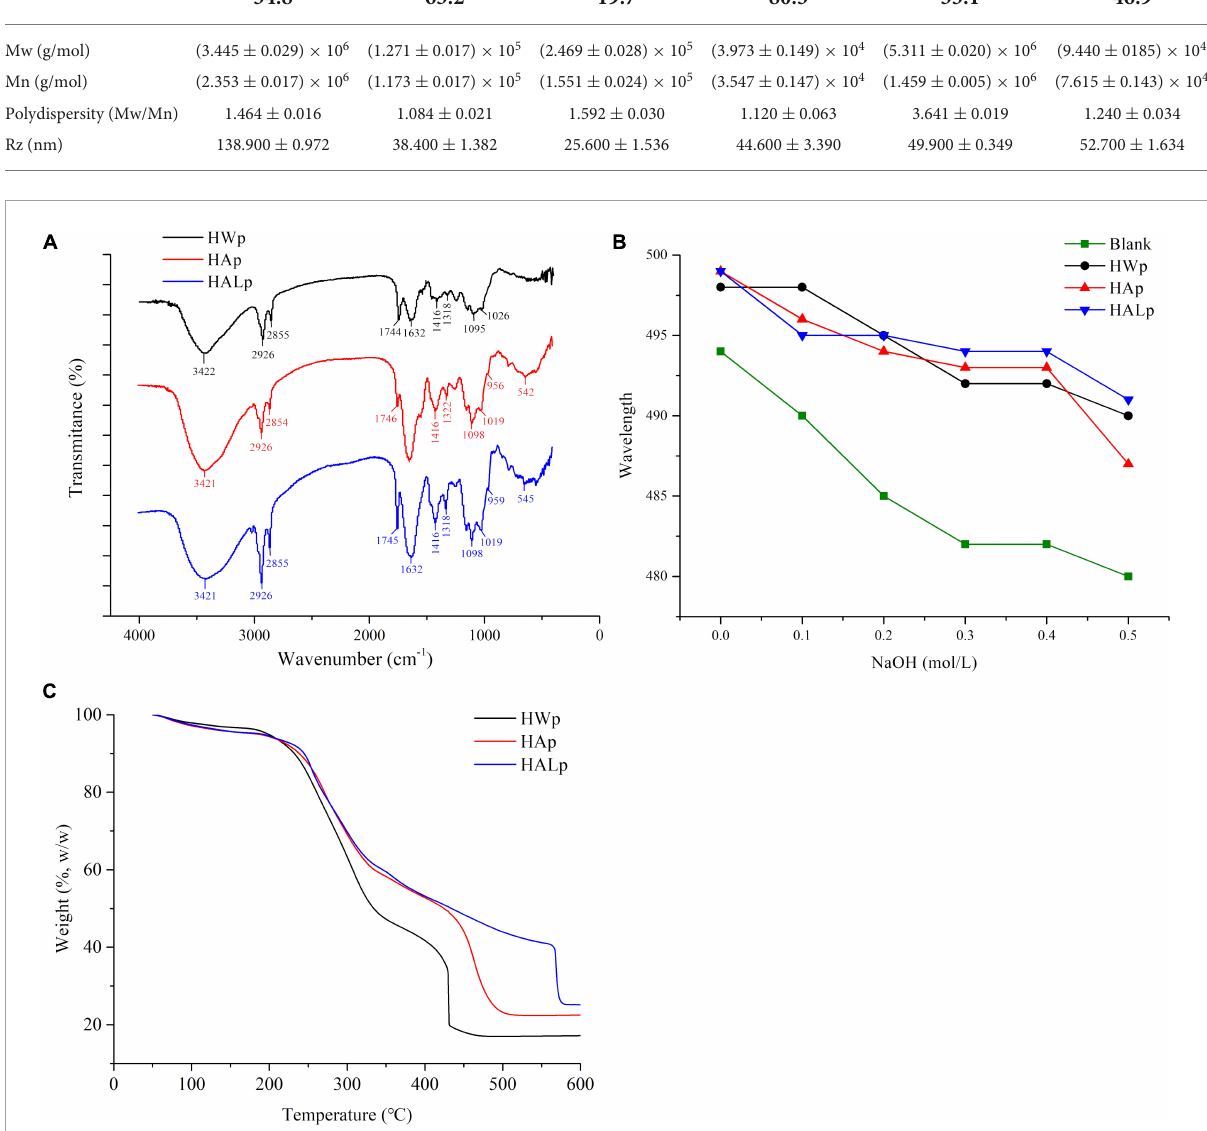
FIGURE1 (A) FT-IR spectra of HWp, HAp, and HALp; (B) characterization of pectin helical structure at different concentrations; (C) thermodynamic properties of HWp, HAp, and HALp: TGA